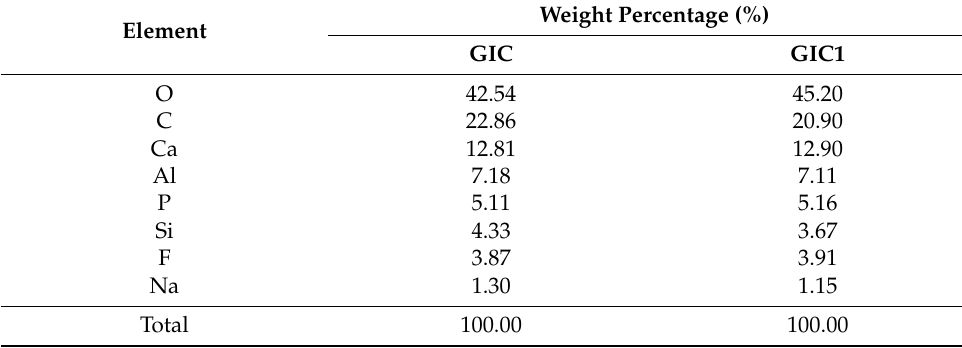
Table 4. Chemical composition of GIC and GIC1 samples at 1 day of ageing